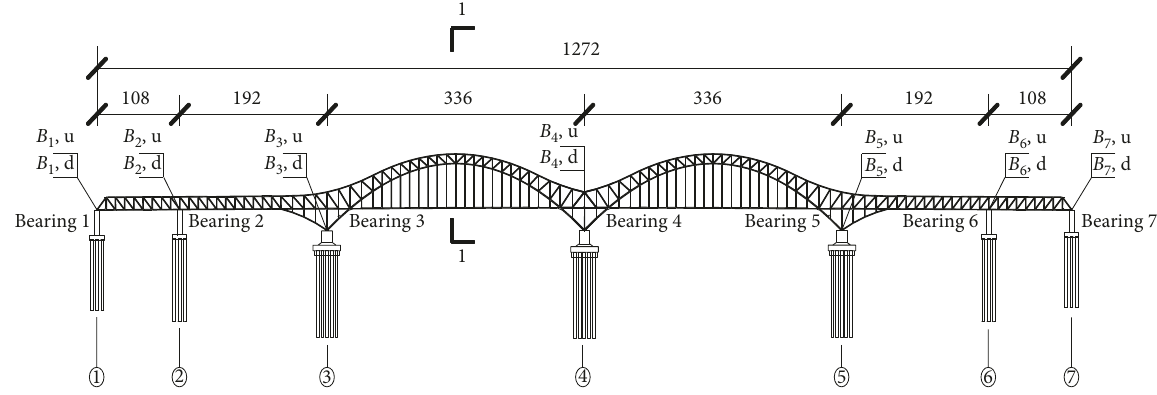
Figure 2: Locations of the longitudinal displacement sensors m